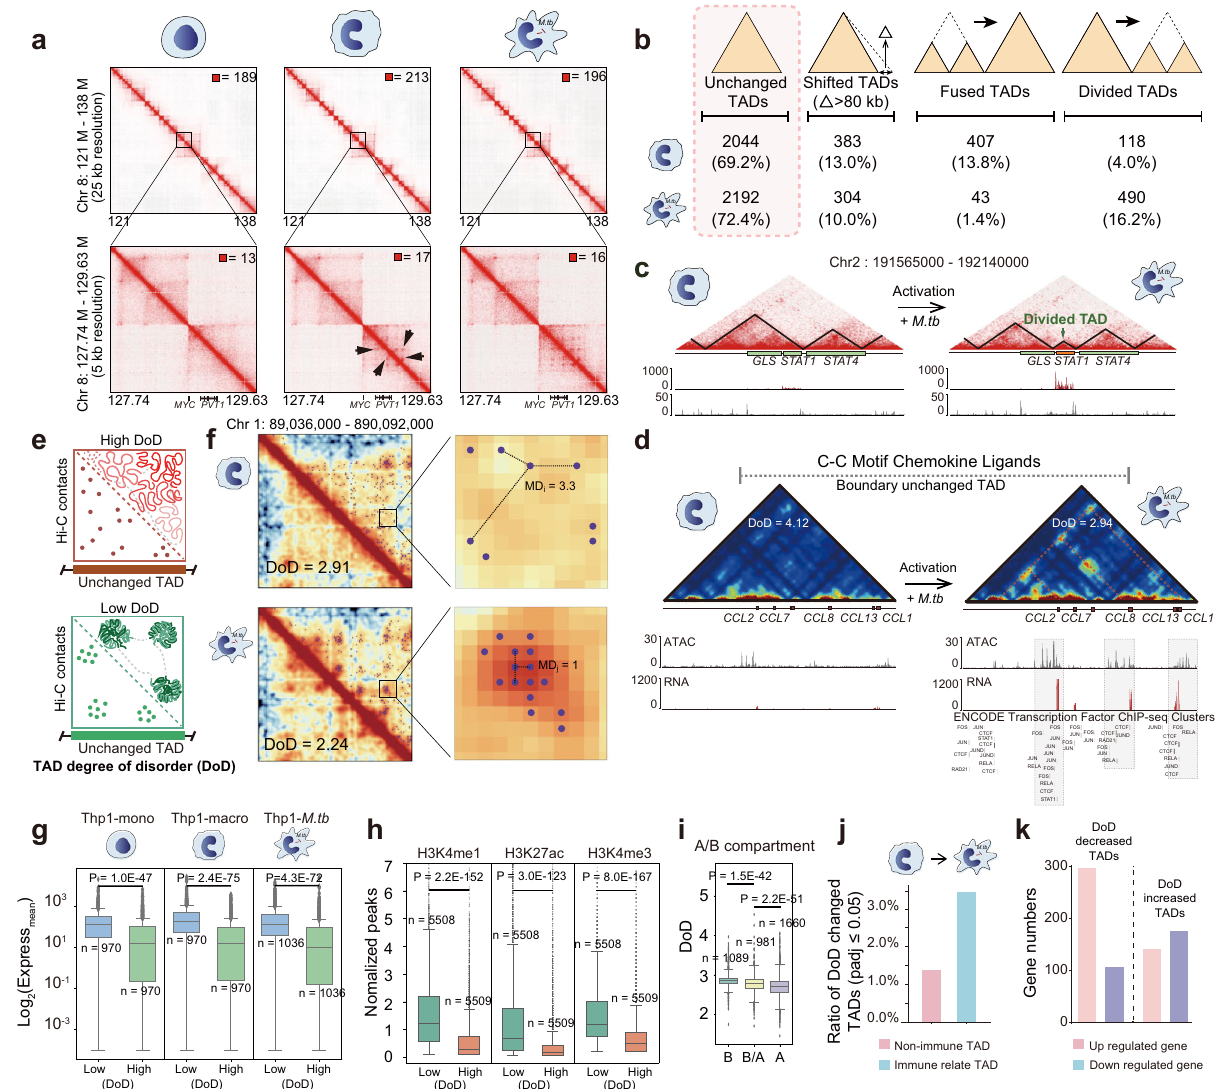
Fig. 2 | DoD (degree of disorder) of innate immune-related TADs during dif- ferentiation and activation. a Hi-C heatmaps at different resolutions. Strong interactions(markedwitharrows)wereobservedaroundthe MYC generegionafter differentiation. b TADdynamicsofTHP-1cellsduringdifferentiationandactivation. c TAD rearrangement, gene expression, and ATAC-Seq peak around STAT1 during M.tb infection. d Typical example of CC chemokine gene cluster. The putative transcription factor (from ENCODE) were labeled with gray box. e The degree of disorder (DoD) was used to evaluate the organizational order of the chromatin architecture in TADs. f Examples of TADs with high and low DoDs and a schematic showing the DoD calculation approach. The P -value for observing interaction fre- quencyiscalculated based onthePoissonprocess.Interactionswith P -value ≤ 0.05 are retained. g Relationship between TAD DoD and average gene expression level (normalized read count). The DoD value higher than median was de fi ned as “ High DoD ” ; lower than the median was de fi ned as “ Low DoD ” . Box-plot with midline= median,boxlimits=Q1(25thpercentile)/Q3(75thpercentile),whiskers=minimum